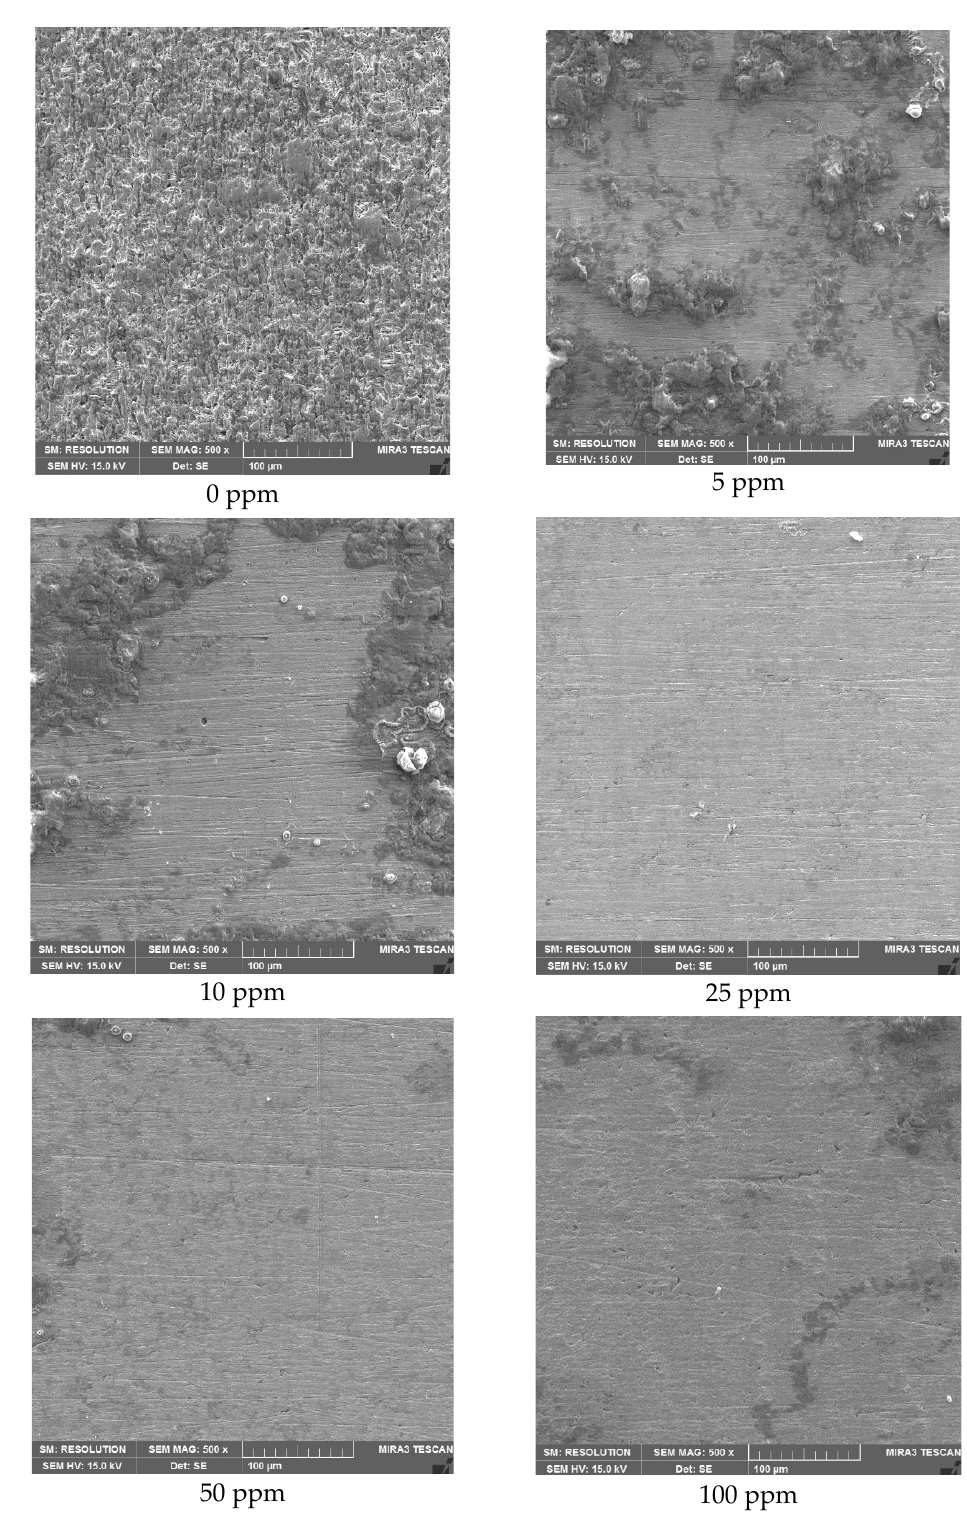
Figure 3. Morphological aspects of the API-X52 steel surface after the corrosion test in CO 2 -saturated brine at 60 °C.